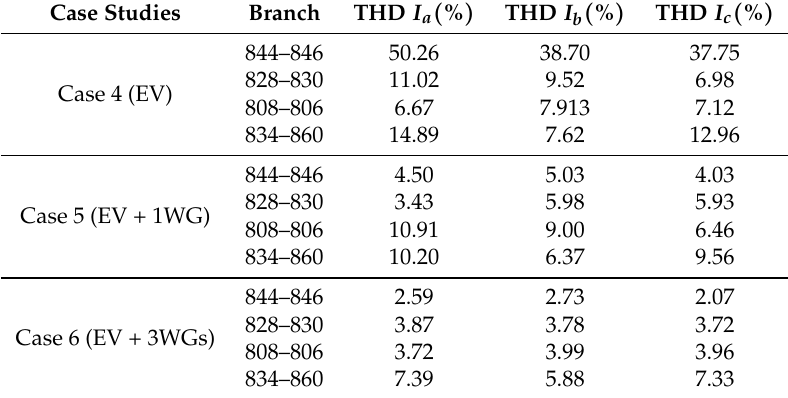
Table 5. Current THDs for High EV